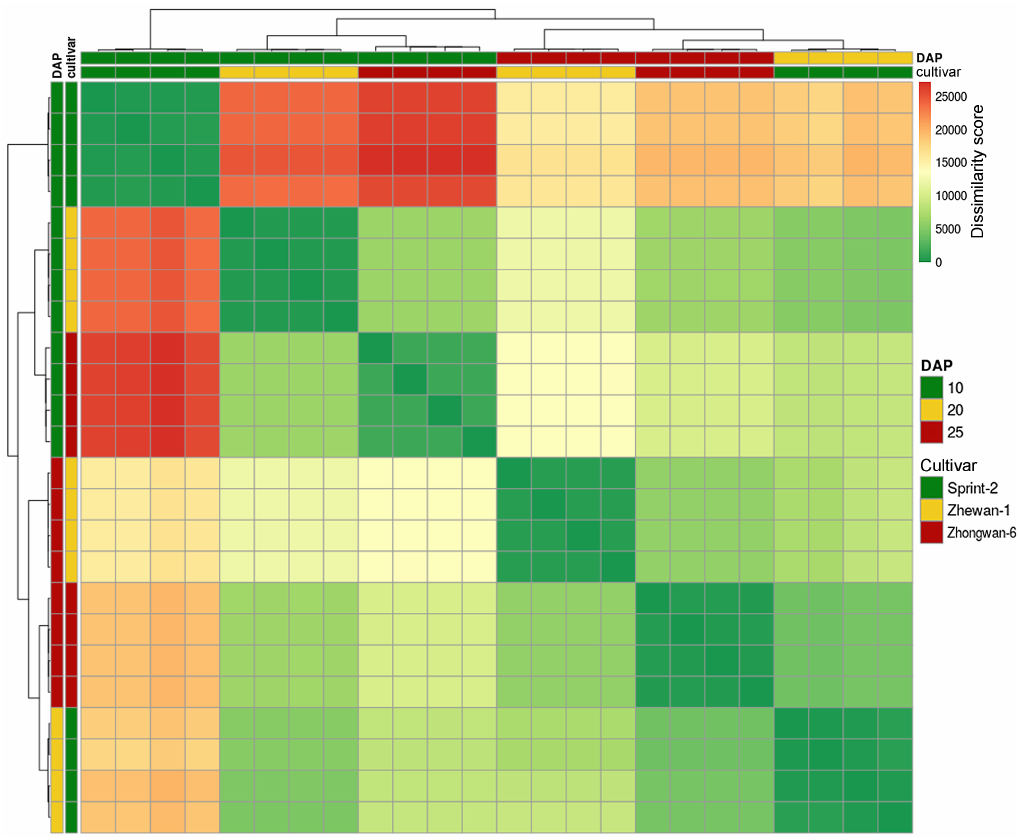
Figure 7. Poissonian clustering of transcriptomic samples. Cells denote transcriptomic profiles expressed for respective samples as transcript per million vectors. Color code indicates the dissimilarity measure based on the Poisson model of read